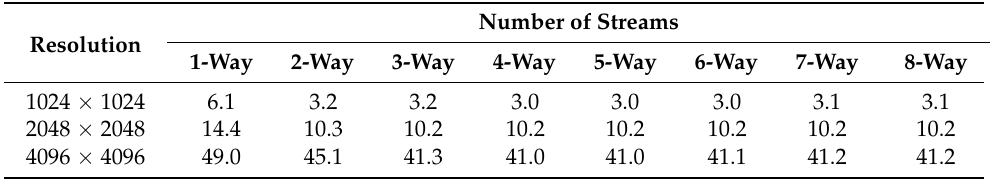
Table 8. BP-VISAR frame generation time with the number of streams in the multi-stream based processing architecture, overlapped mode ( α = 0.8, unit: ms). Resolution